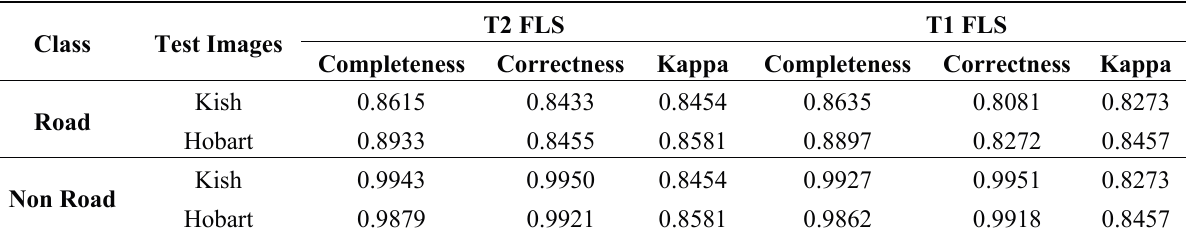
Figure 10. Training and testing evaluation: ( a,b ) The referenced road data of Hobart and Kish IKONOS image; ( c , d ) The final result of proposed road detection method from Hobart and Kish IKONOS image. Table 6. Final evaluation of Hobart and Kish